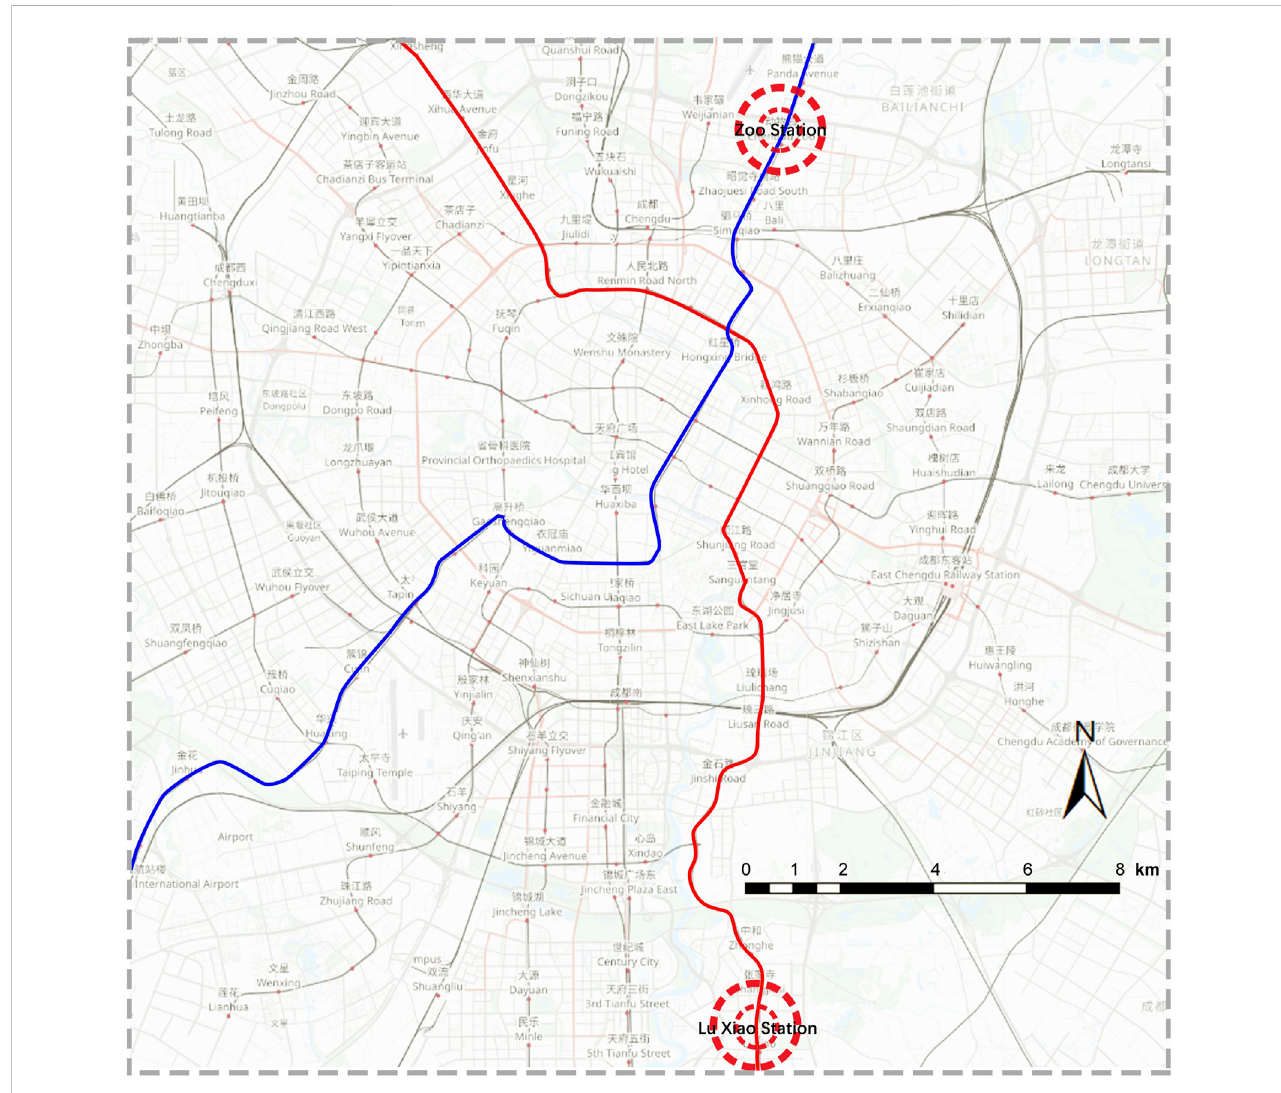
FIGURE 1 Distribution location of two metro stations (https://www.openstreetmap.org/relation/3287346).